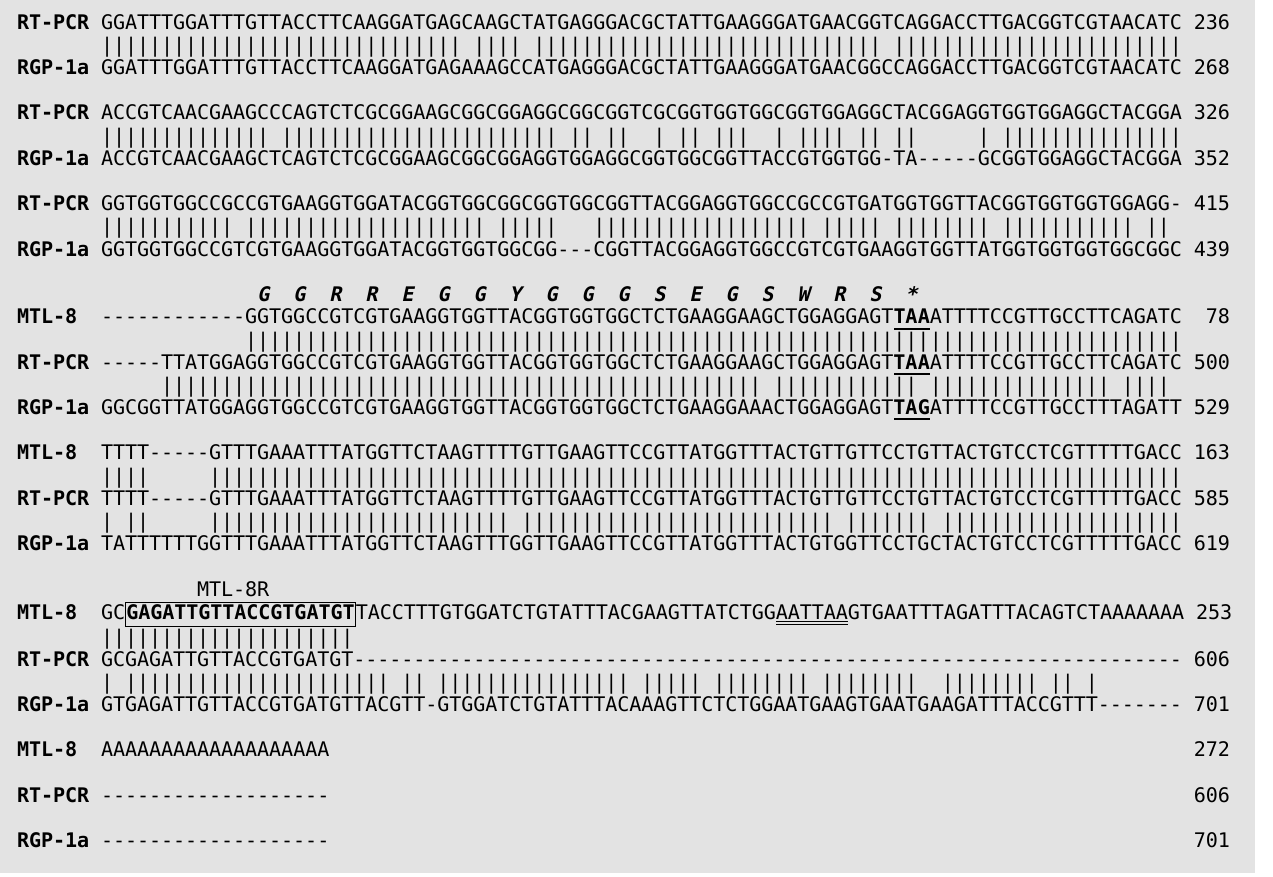
Figure 1. Alignment of the nucleotide sequences of MTL-8 cDNA, the RT-PCR fragment and glycine-rich RNA-binding protein (RGP-1a) from Nicotiana sylvestris (accession number D16024). Vertical bars indicate identical nucleotides and dashes indicate gaps introduced to obtain the best alignment. The translation start and termination codons are shown in bold underlined letters, and the putative polyadenylation signal is underlined twice. The deduced amino acid sequence of the MTL-8 cDNA clone appears in bold italic letters above the MTL-8 nucleotide sequence. The sequences corresponding to the MTL-8F and MTL-8R primers are shown in bold letters inside